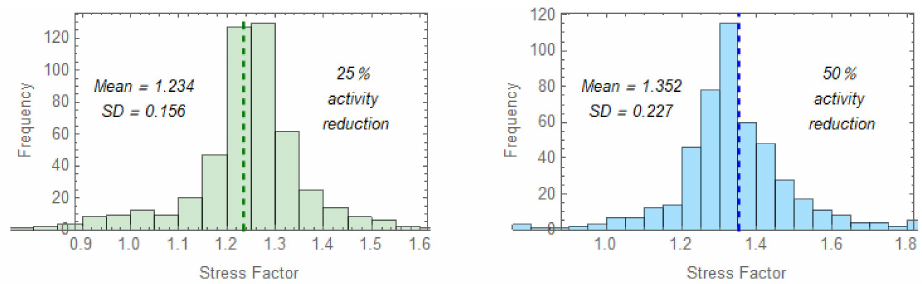
Figure 7. COVID-19 reduced activity scenarios, each with 25000 Monte Carlo iterations. The dashed lines show the position of the vertical dashed lines show the position of the means.